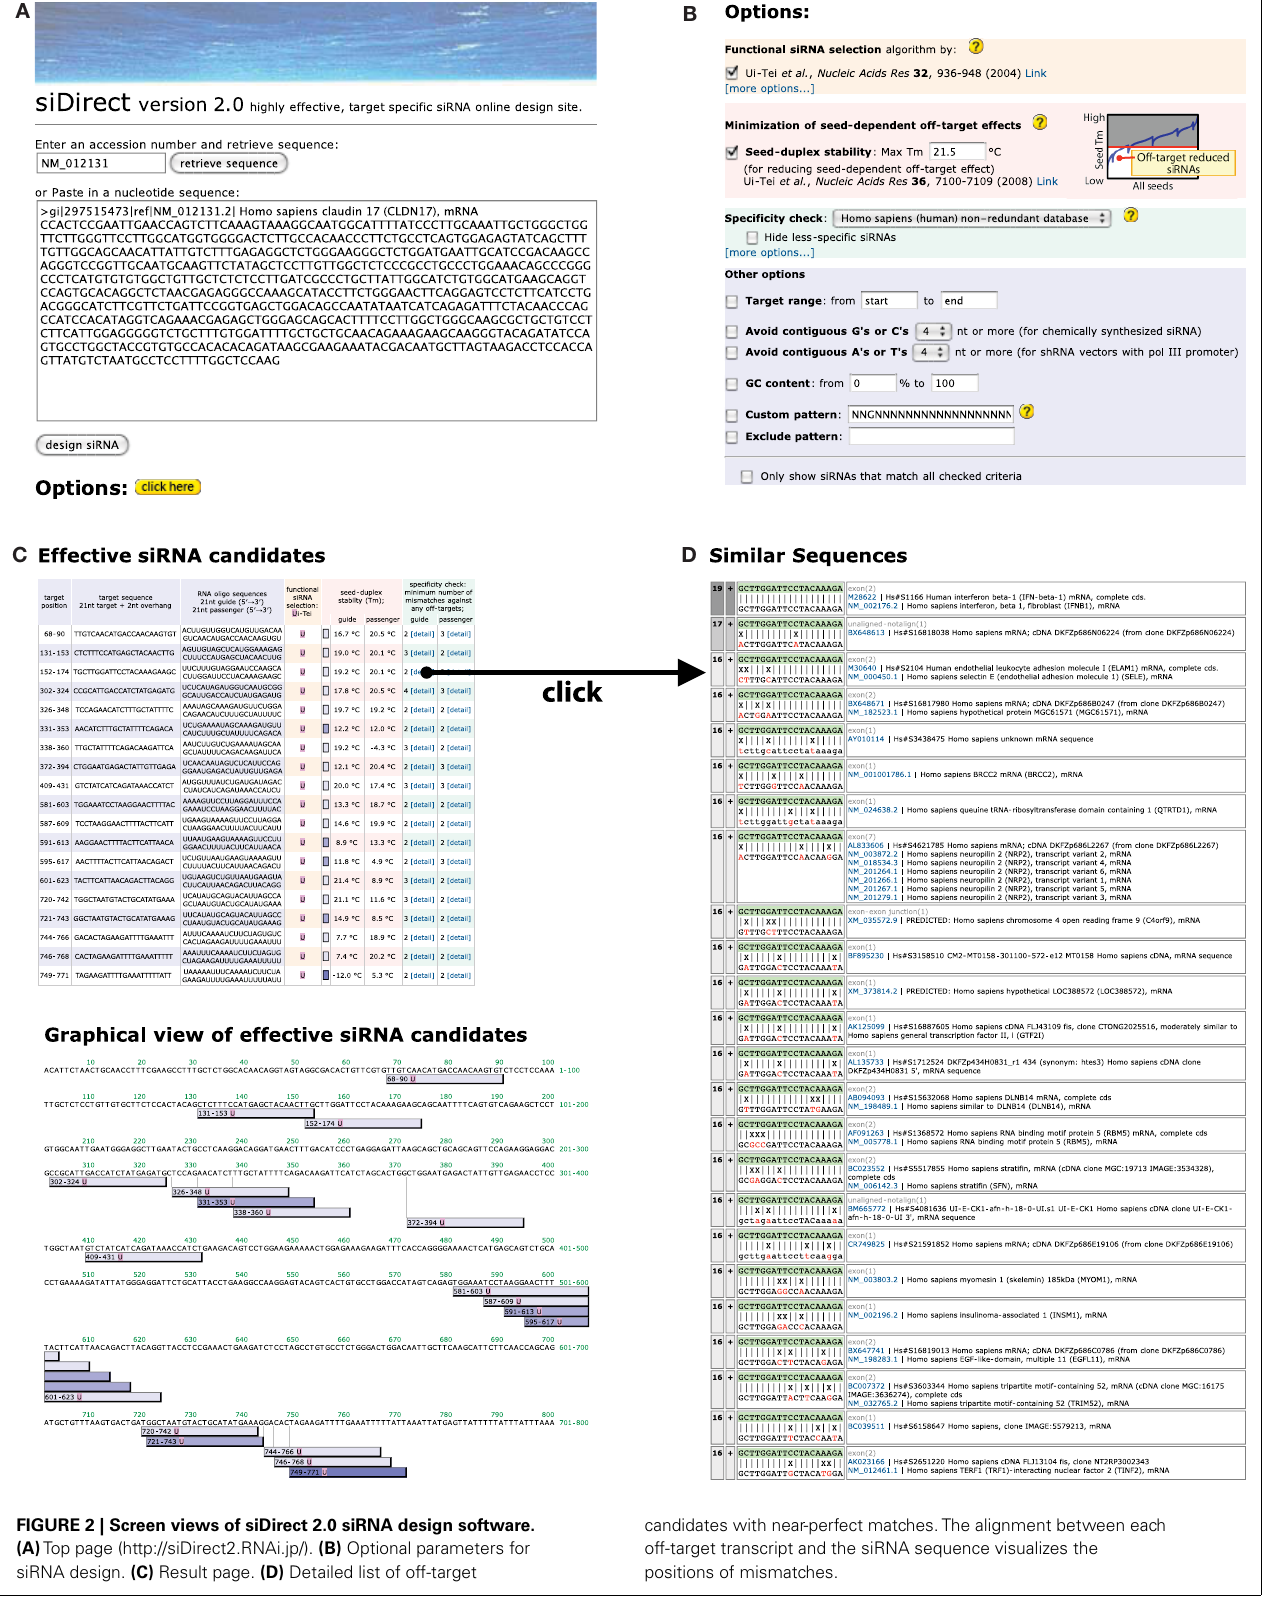
candidates with near-perfect matches.The alignment between each off-target transcript and the siRNA sequence visualizes the positions of